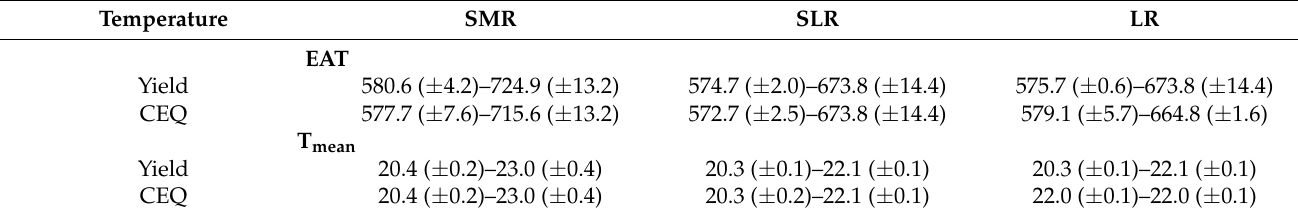
Table 9. The range of suitable sowing dates over the years was deduced according to the require- ment of EAT in the grain filling stage for rice to obtain good eating quality 1.